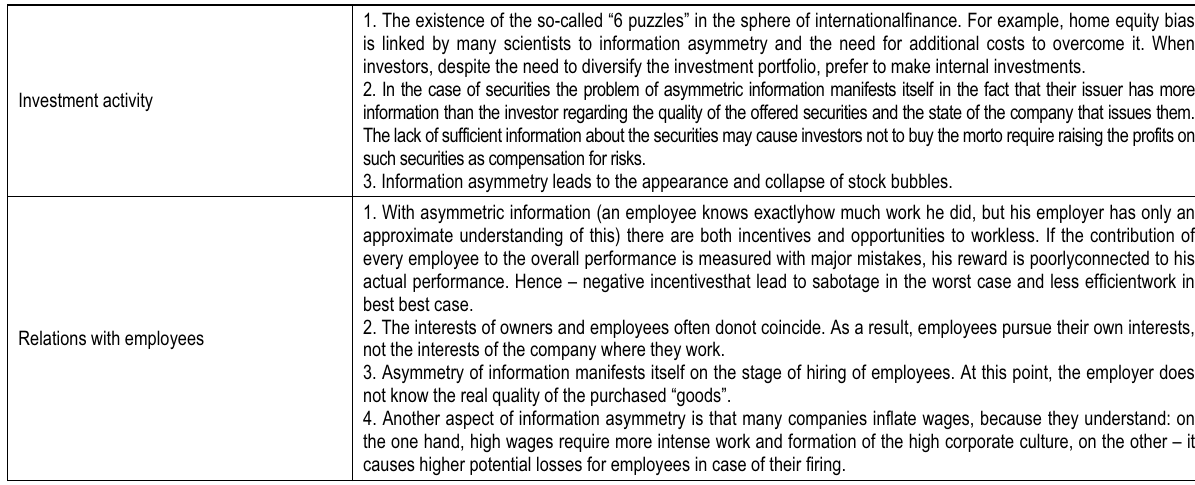
Table A.1 (cont.). Examples of information asymmetry on the market of non-banking financial services in Ukraine